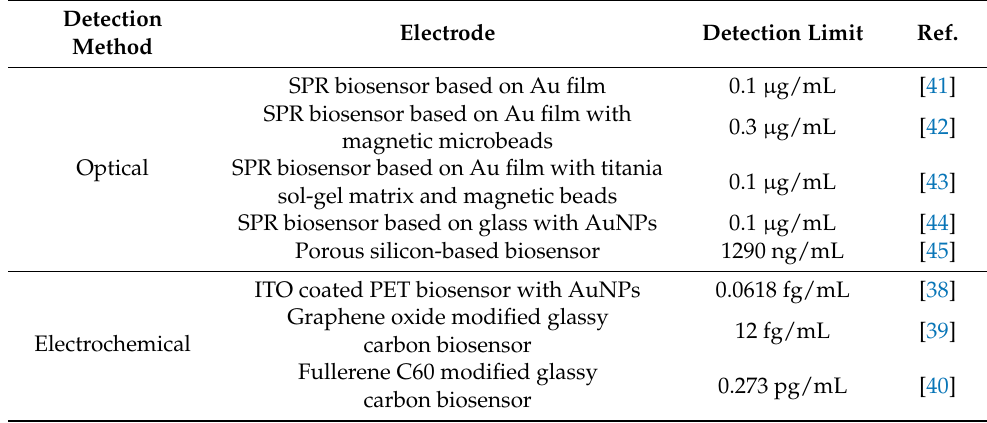
Table 1. HSP70 biosensors developed by